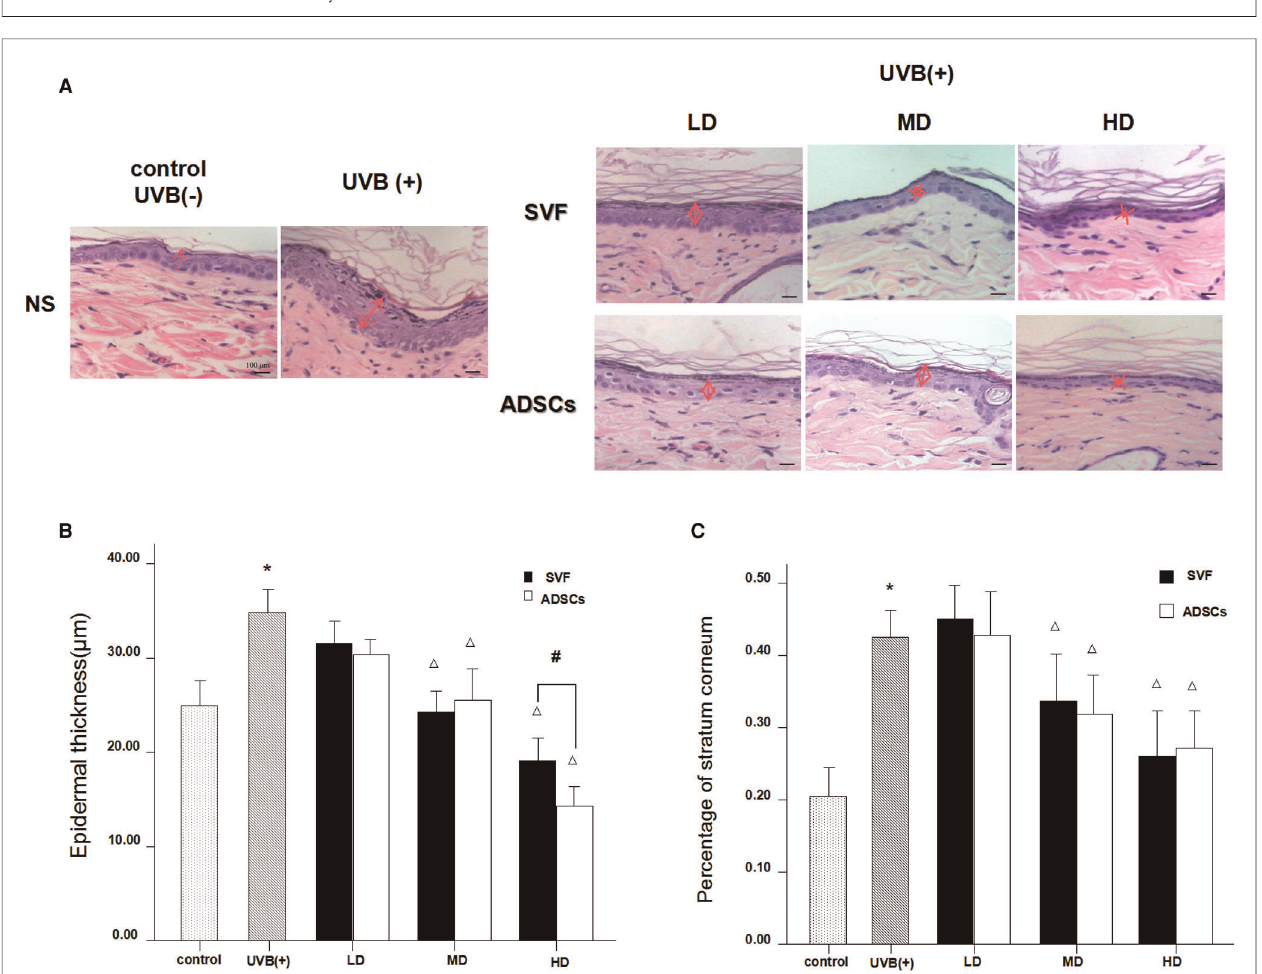
FIGURE 3 | Haematoxylin staining showed the changes of epidermal thickness of nude rats exposed to UVB 7 days after SVF treatment and ADSCs treatment (×400). ( A ) UVB exposure decreased the epidermal thickness of nude rats and SVF and ADSCs treatment increased the epidermal thickness of aging skin. ( B ) The epidermal thickness of UVB exposed group and SVF and ADSCs treatment groups. ( C ) Percentage of stratum corneum of UVB exposed group and SVF and ADSCs treatment groups. Mean±SD. n =6. * P <0.05 vs control group. △ P <0.05 vs UVB(+) group. # P <0.05 between the groups with line